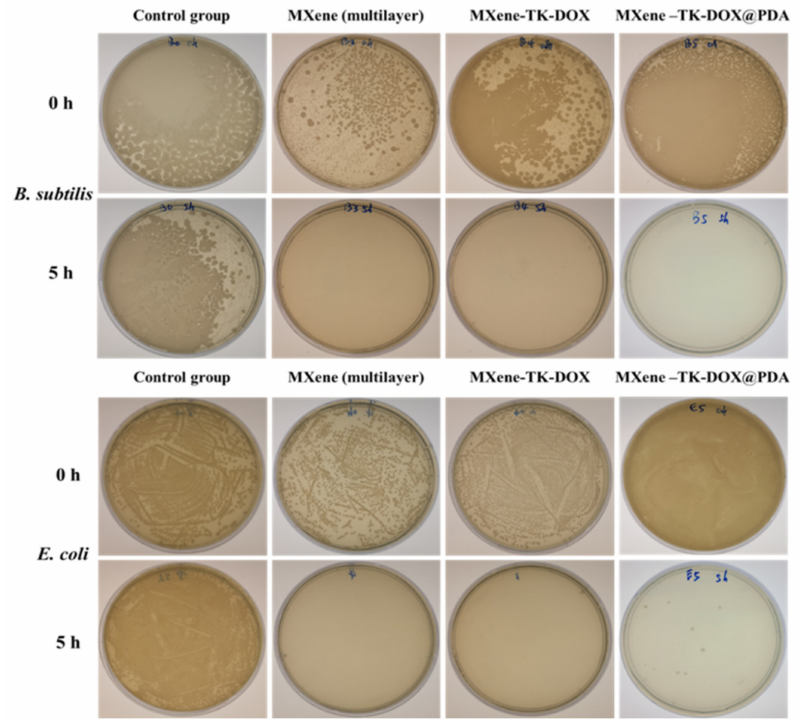
Figure 10. Antibacterial activities in aqueous solutions after 5 h of incubation: bacterial suspensions in PBS solution (0.01 mM) acted as the control group. A photograph of the test plates for E. coli and B. subtilis bacteria exposed to the MXene, MXene − TK − DOX, and MXene − TK − DOX@PDA nanoparticles at a concentration of 6.085 mg/mL, respectively. All analyses of the results were performed in